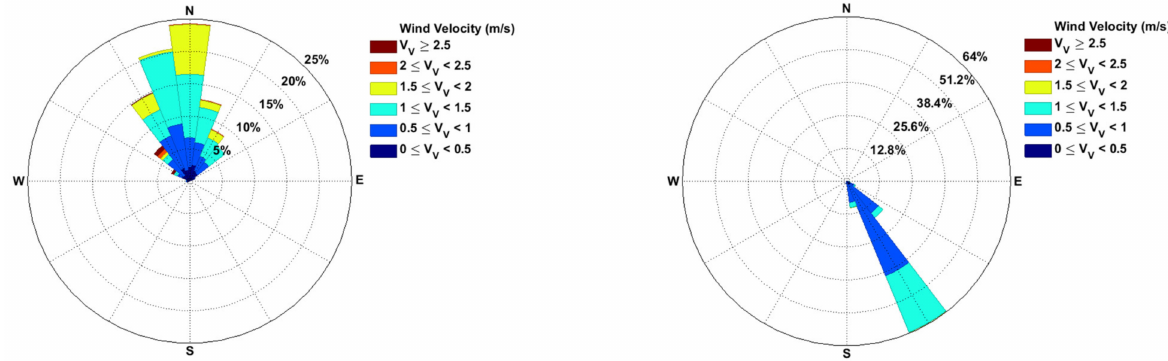
Figure 15. Wind rose for the full day and during land breeze occurrences for Barbosa station in the left panels and for Cid Almeida station in the right panels on 1 January